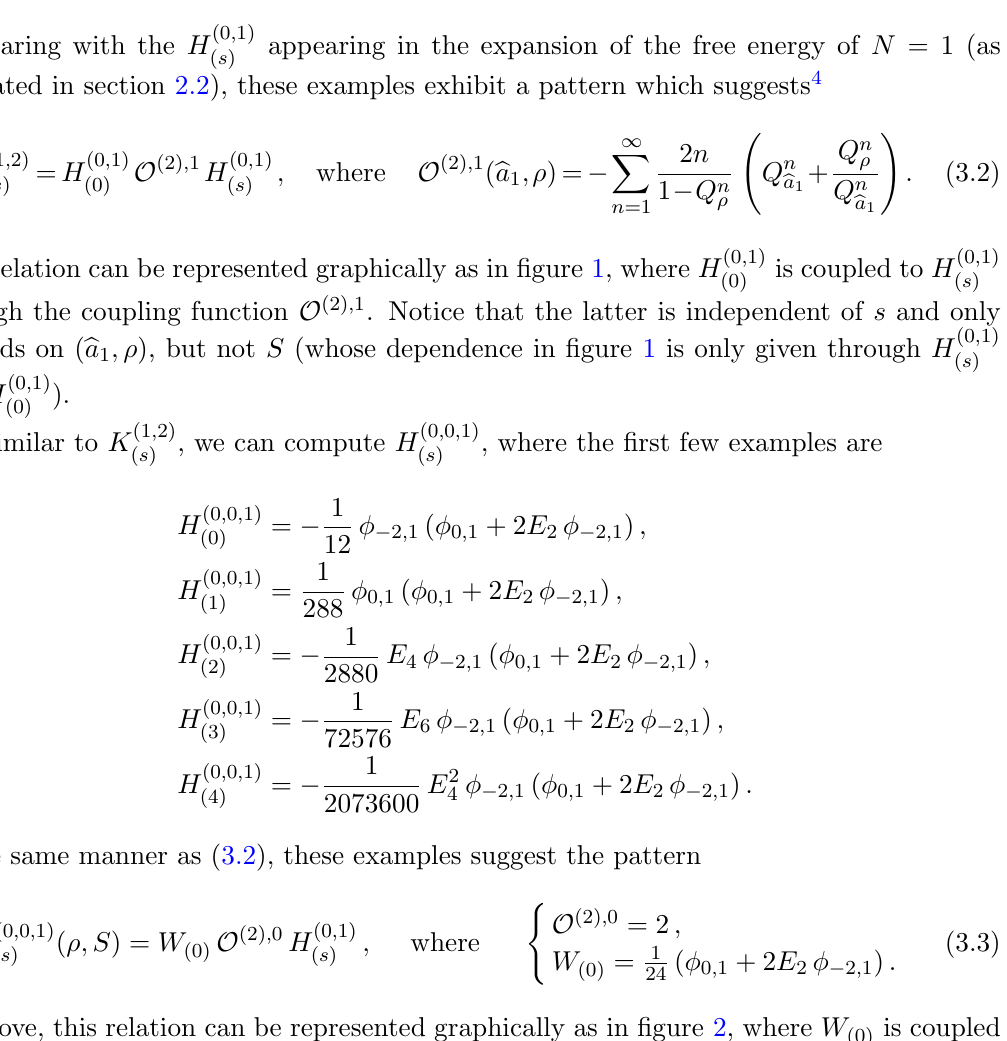
Comparing with the H (0 ; 1)